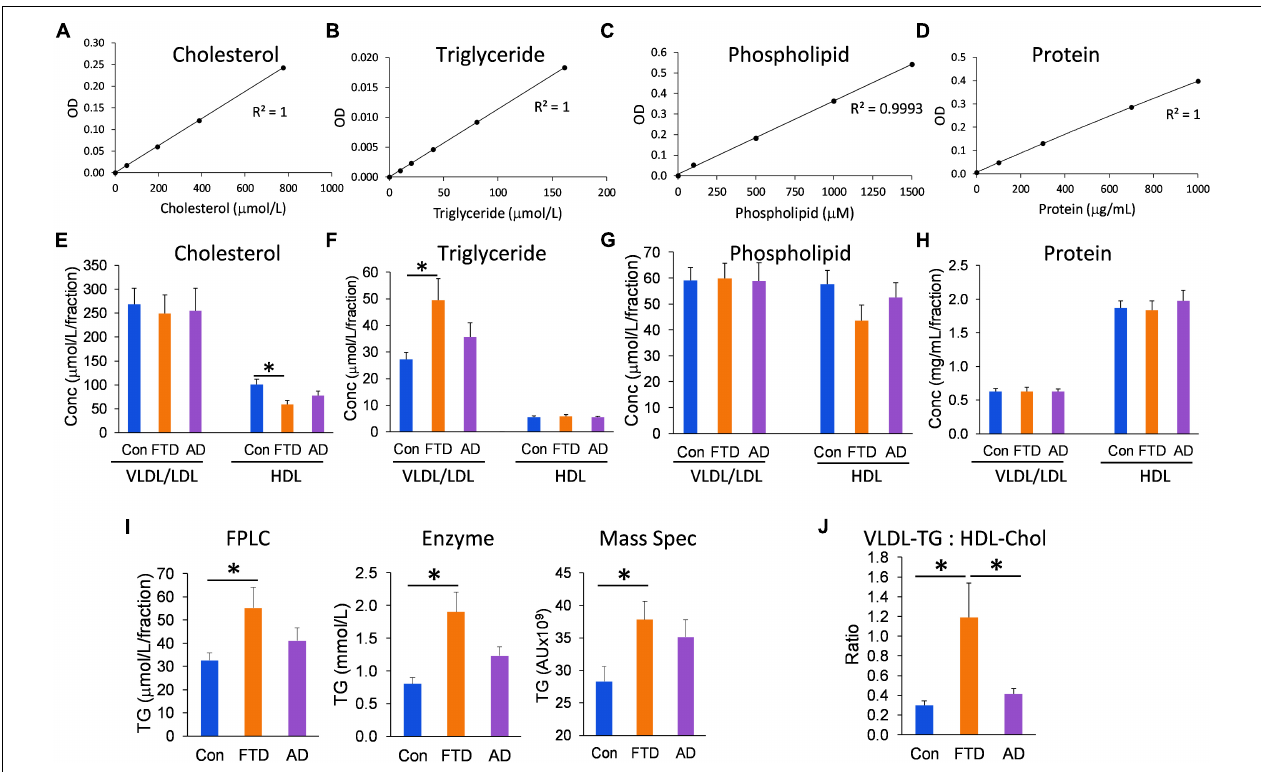
FIGURE 3 | Lipid and protein levels in lipoproteins in bvFTD, AD, and controls. (A–D) Lipid and protein assay standard plots with R 2 value. (E–H) Concentrations of lipids and protein in HDLs and VLDLs/LDLs in bvFTD, AD, and controls. (I) A comparison of total triglyceride measurements using FPLC, enzyme-based assay, and mass spectrometry. (J) The VLDL-triglyceride:HDL-cholesterol ratio is significantly increased in bvFTD compared to AD and controls. Data represent mean and SE as error bars, ∗ p <